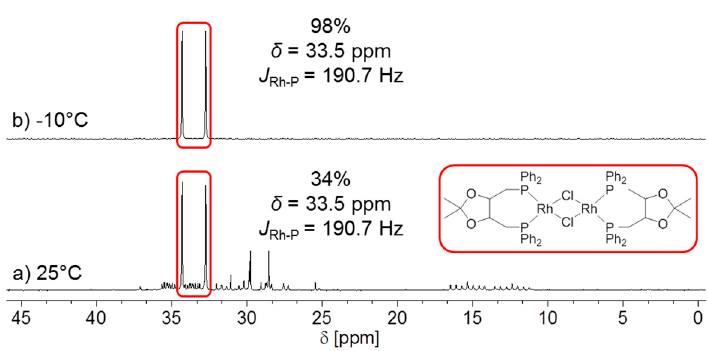
Figure 5. 31 P NMR spectrum of the solution resulting from the in situ reaction of [Rh(COD)( µ 2 -Cl)] 2 and DIOP in THF- d 8 at ( a ) 25 °C and ( b ) − 10 °C.